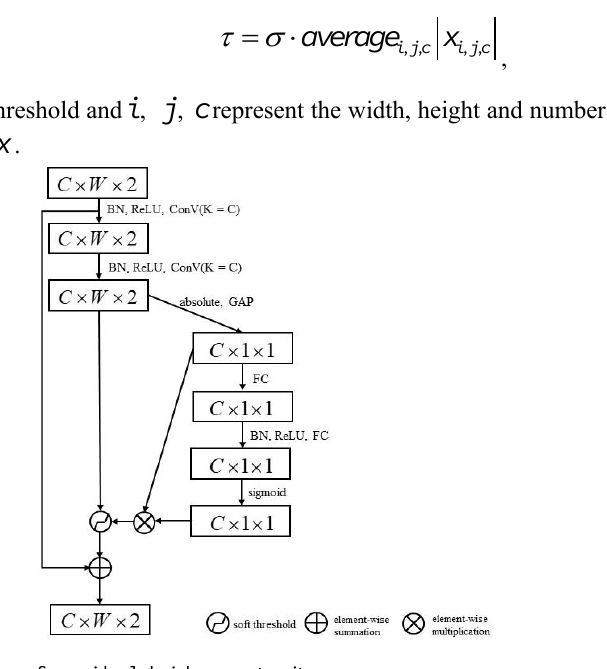
Fig. 1. The structure of a residual shrinkage net